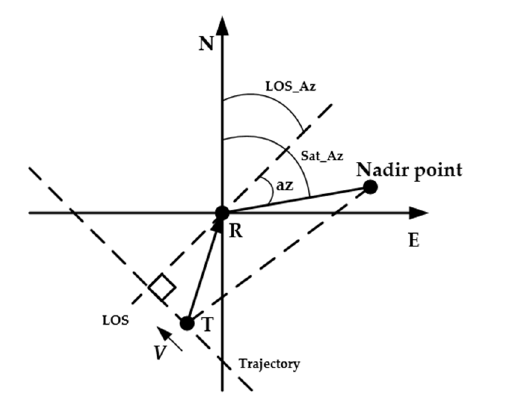
Figure 11. Top view of the real scene. Table 3. Automatic identification system (AIS) information and the selected GPS satellites.